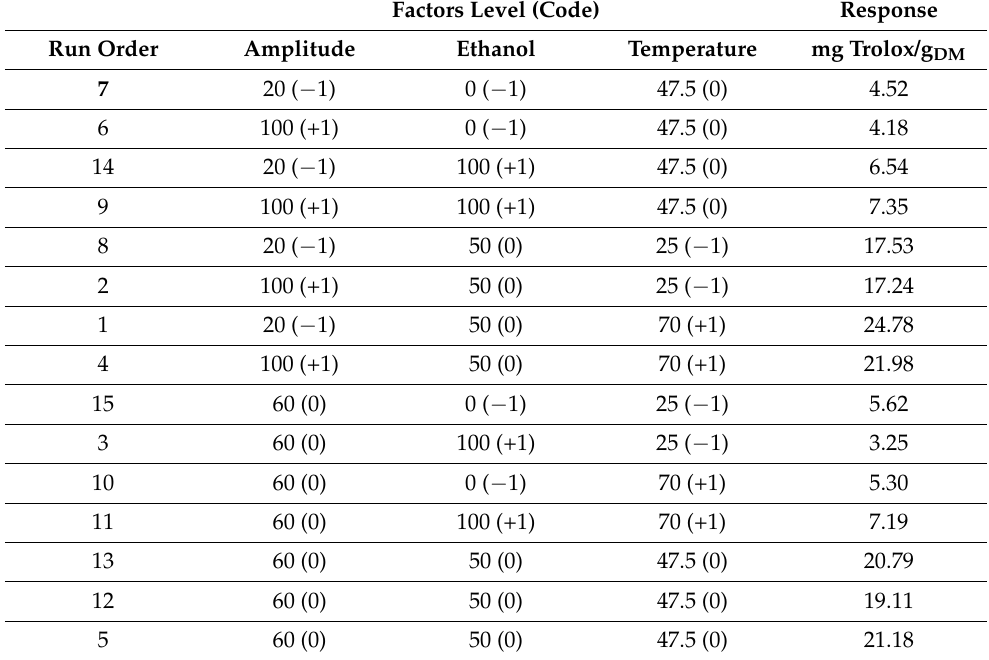
Table 1. Variables and levels used in the Box–Behnken